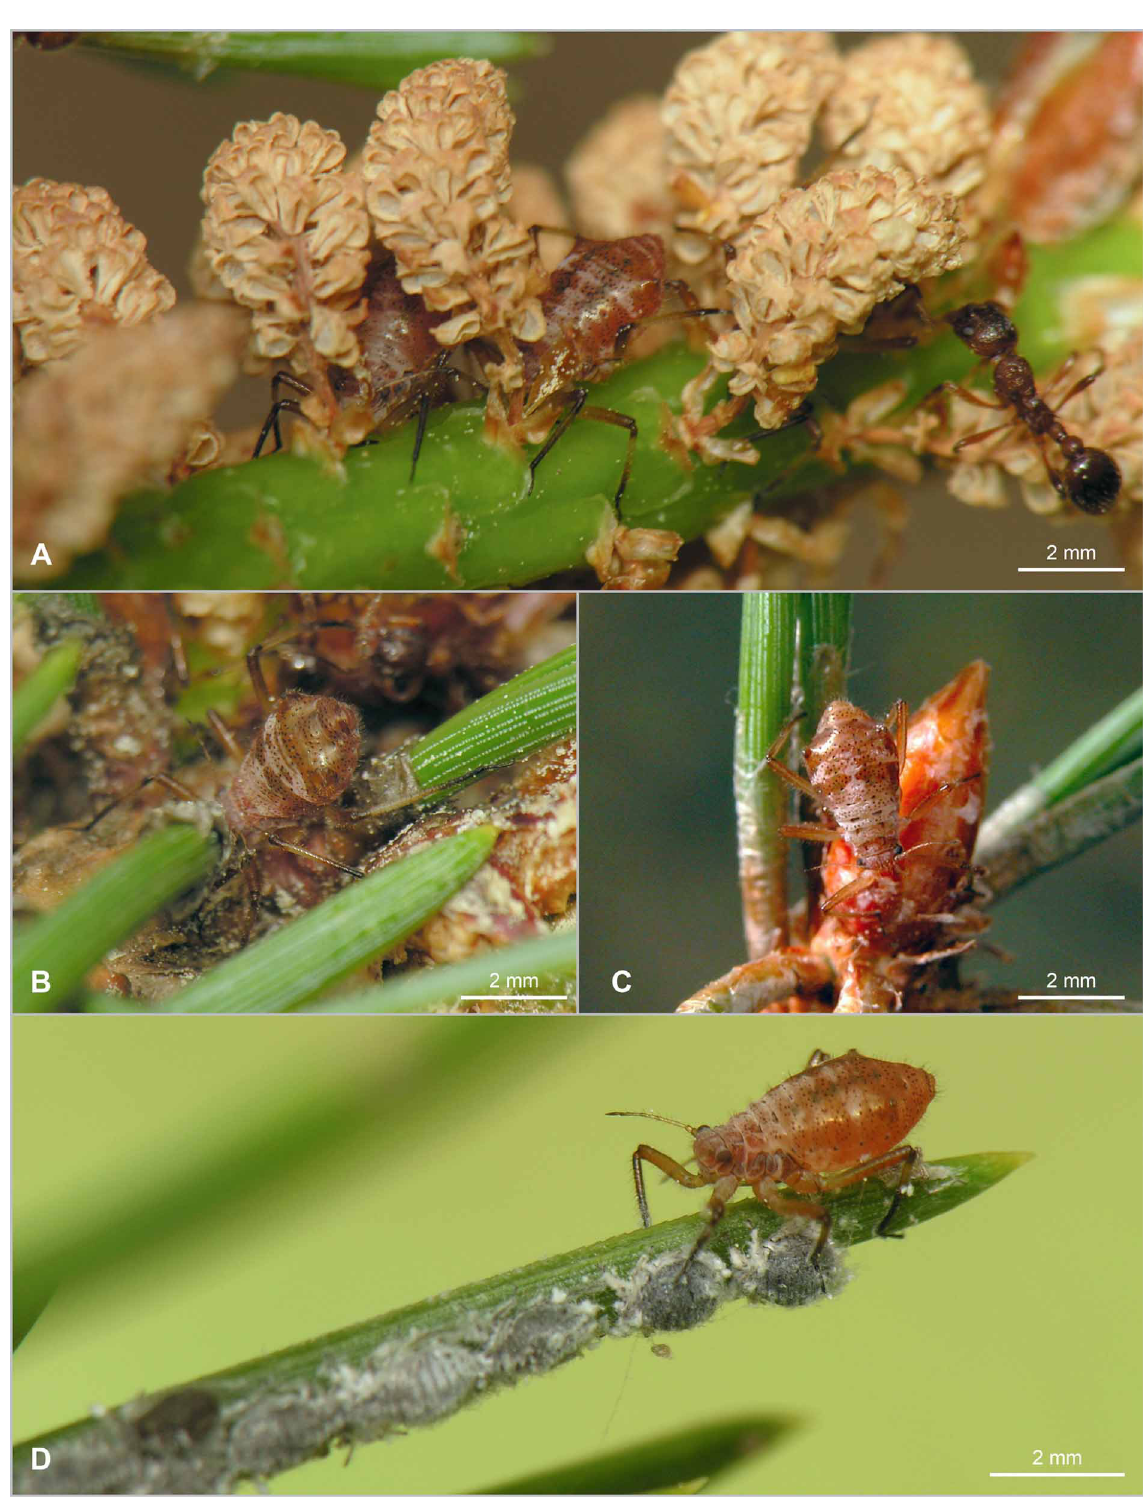
Fig. 99. Cinara (Cinara) pilosa (Zetterstedt, 1840). Apterae on old Pinus sylvestris . A–B . Small colony between and below male flowers, attended by Myrmica rubra (Linnaeus, 1758). C . Aptera on terminal bud. D . Aptera on needle in colony of Schizolachnus pineti